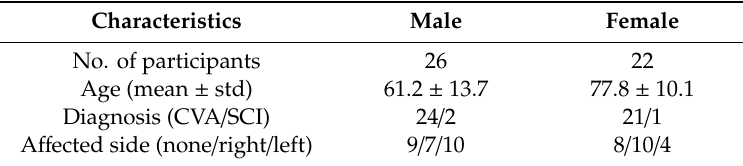
Table 1. Demographic information of study